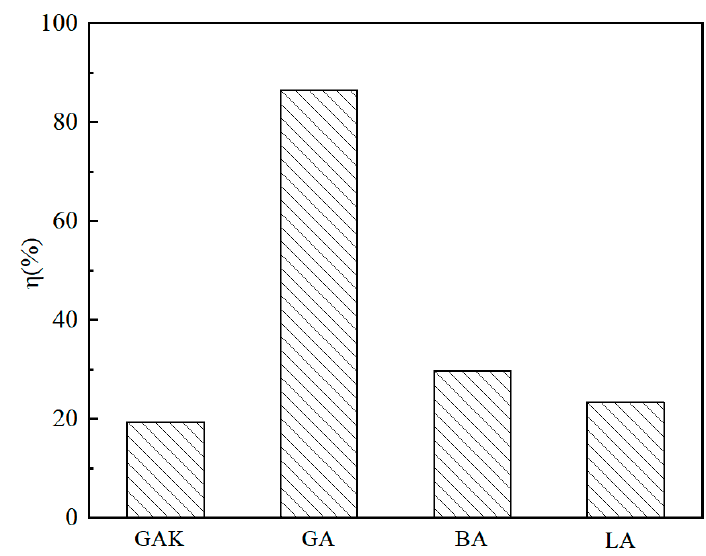
Figure 6. The mass-loss rate of asphalt coated different aggregates in the boiling test.